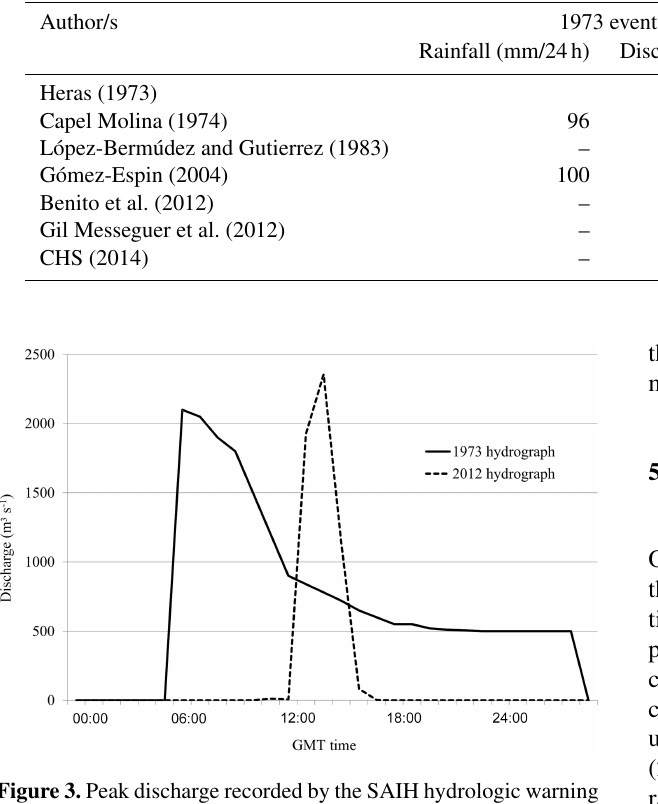
Figure 3. Peak discharge recorded by the SAIH hydrologic warning system for the Nogalte Rambla in Puerto Lumbreras during the 28 September 2012 flood and comparison with the hydrograph of 1973